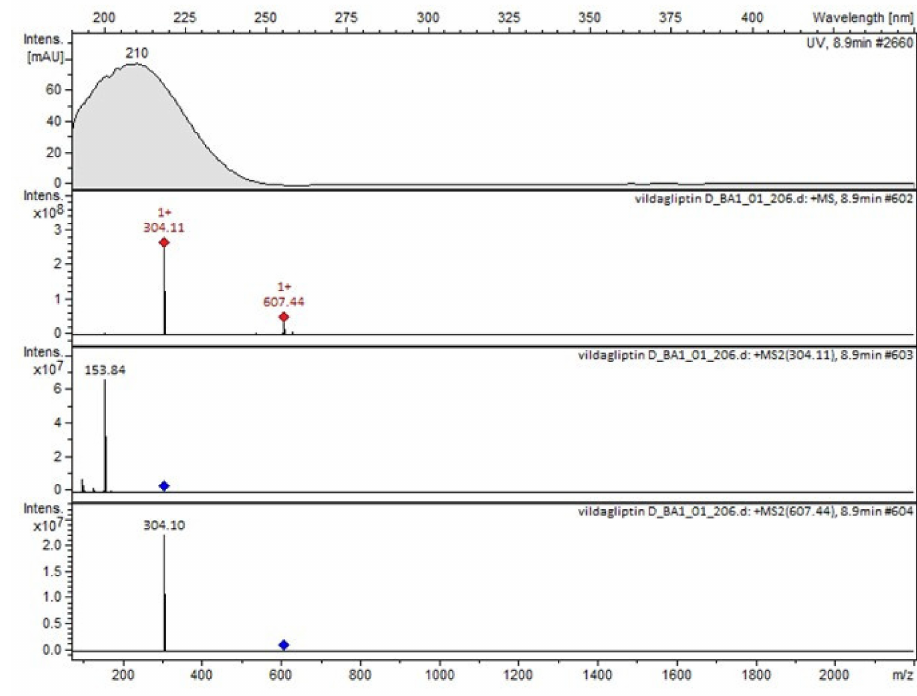
Figure 5. MS and UV/VIS spectra of vildagliptin (V).